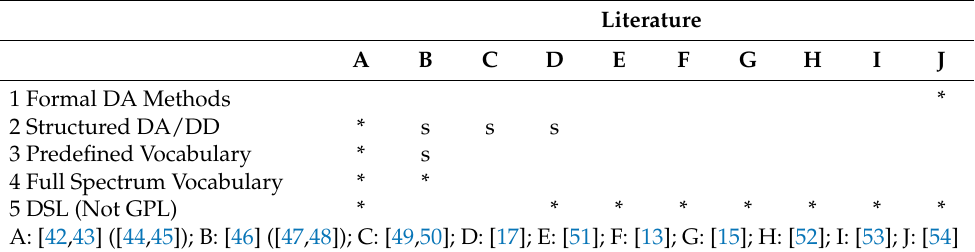
Table 3. The domain analysis in the computer game